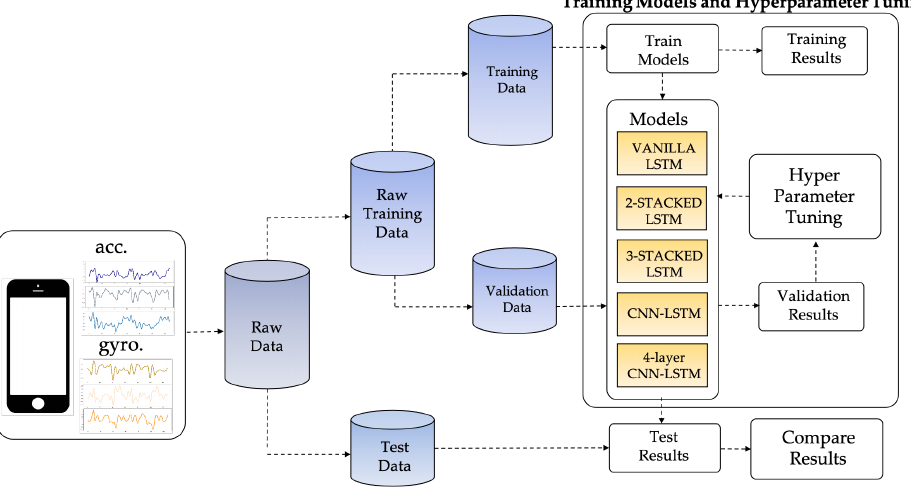
Figure 4. The proposed framework of LSTM-based